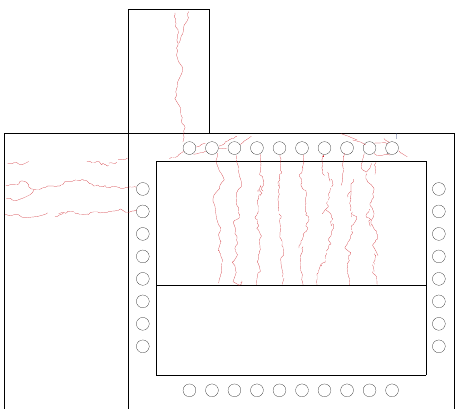
Figure 7. Crack distribution of hollow specimen.